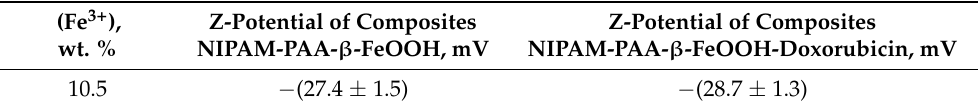
Table 3. Electrokinetic characteristics of magnetic microgels based on NIPAM-PAA-FeO(OH) and doxorubicin-loaded magnetic microgels.